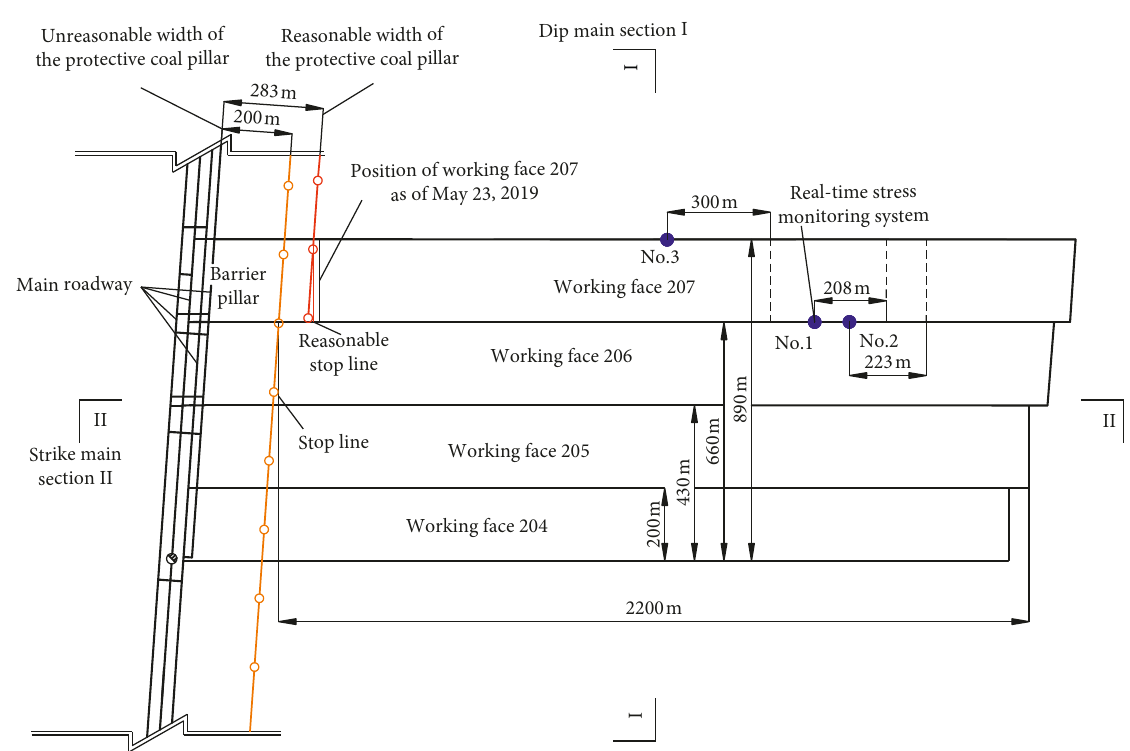
Figure 1: Layout sketch map of the working area in the second